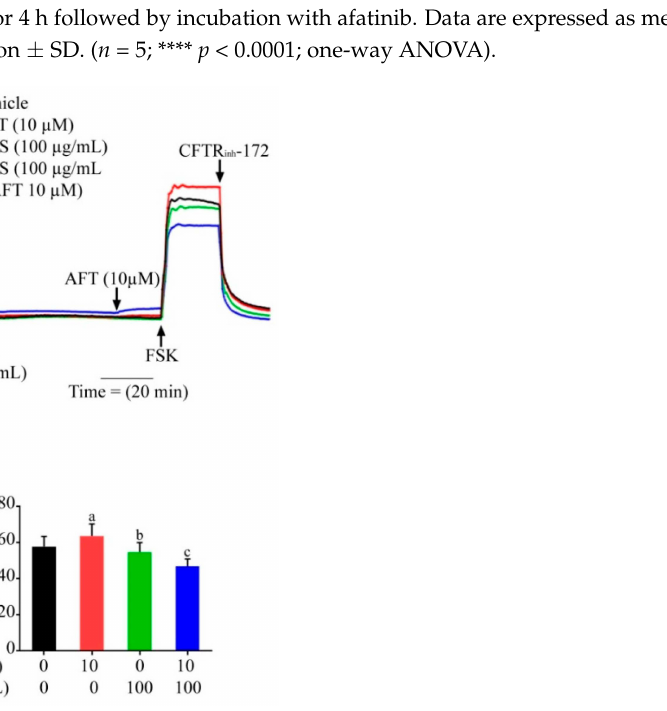
Figure 3. Effect of COS on afatinib-induced Cl − secretion. T84 cell monolayers were mounted in Ussing chambers and treated with the vehicle control, COS, or afatinib alone or in combination. Chloride secretion was then induced with forskolin and quantified as the change in short circuit current ( ∆ I sc ). Data are expressed as means of I sc ± SD. ( n = 5; p < 0.05; one-way ANOVA). Columns not sharing the same superscript letters differ